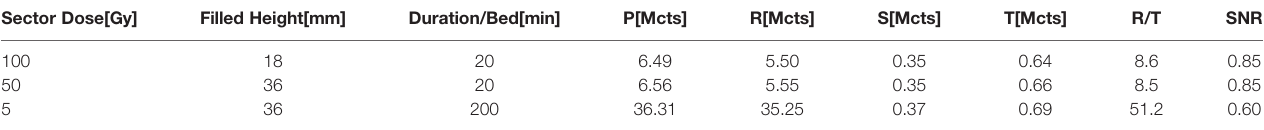
TABLE 1 | True (T) + scatter (S) coincidences numbers acquired on the 550ps TOF-PET for the three 90 Y phantom setups. Sector Dose[Gy] Filled Height[mm] Duration/Bed[min]